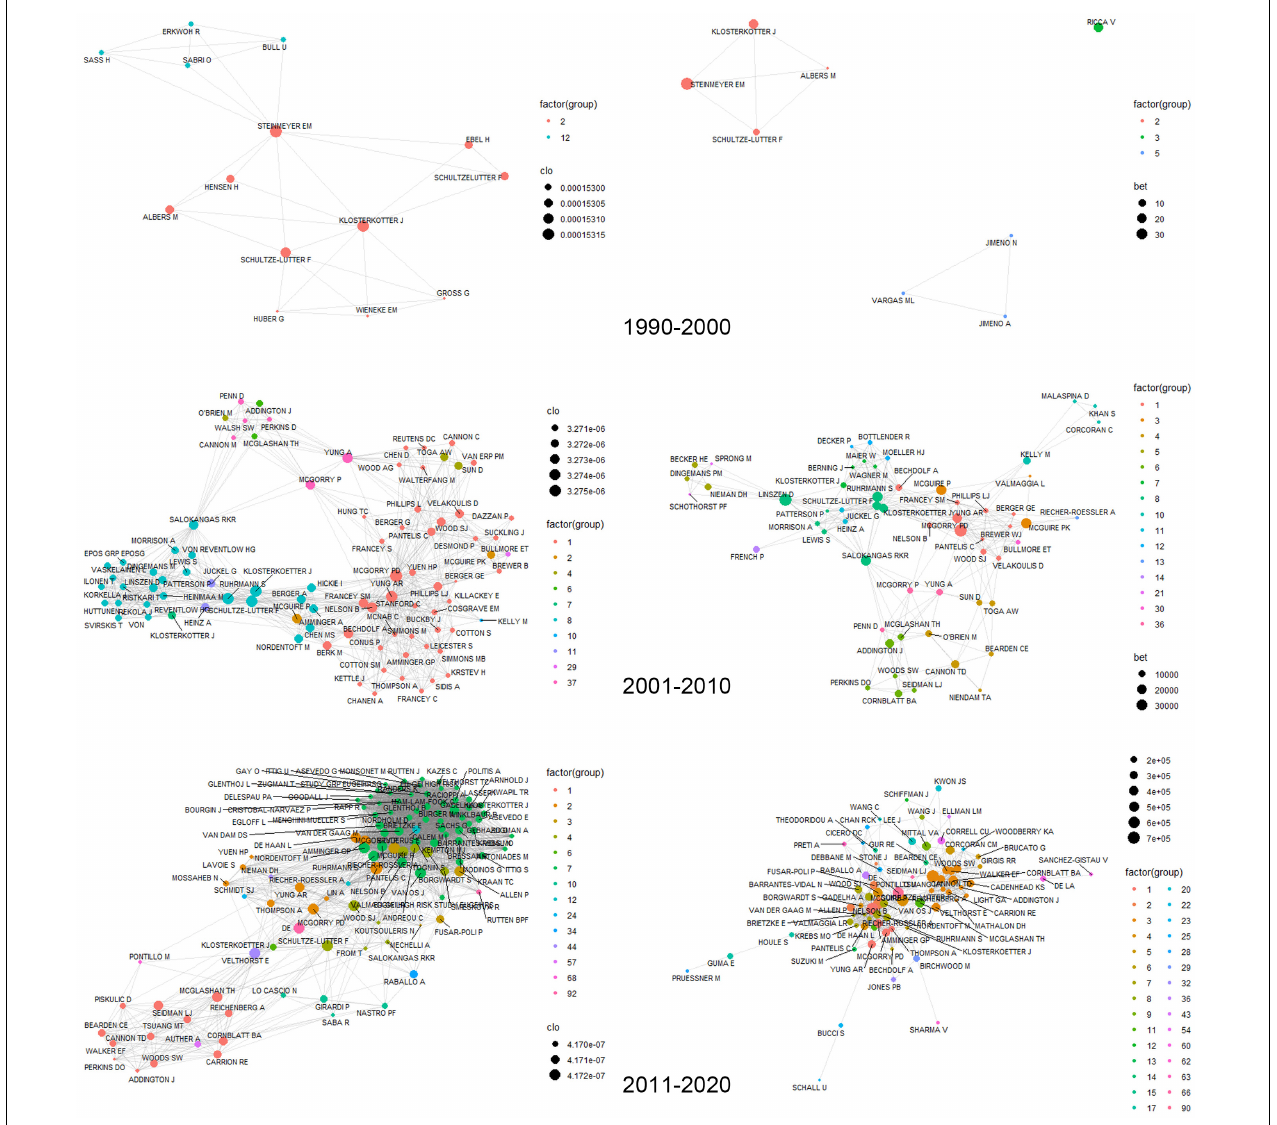
FIGURE 2 | The collaboration network among the authors over a decade. The figure on the left is the closeness centrality and the figure on the right is the betweenness